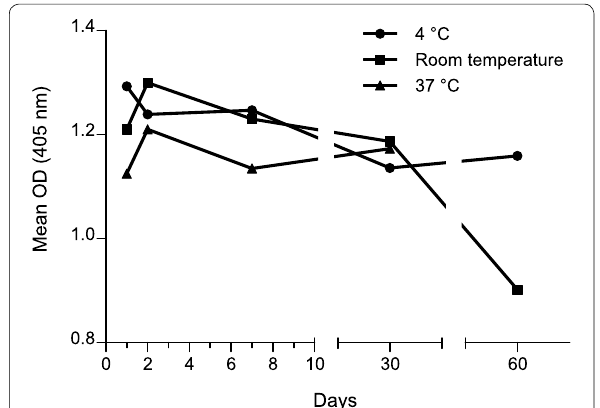
Fig. 5 Analysis of IBDV-SVP stability by ELISA. Aliquots of SVP were stored for 1, 2, 7, 30, or 60 days at room temperature (RT), at 4 °C or 37 °C, and then assayed in the ELISA SVP using 1:400 and 1:4000 dilutions of anti-IBDV and anti-chicken HRP antibodies, respectively. Stability at 37 °C was monitored for 30